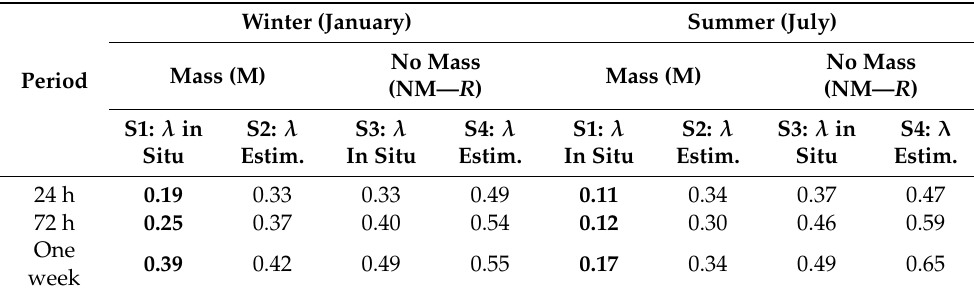
Table 7. Root mean square error (RMSE) between in situ air temperature measurements and simula- tions in ◦ C. In bold: simulated values that are closer to the measured temperatures.